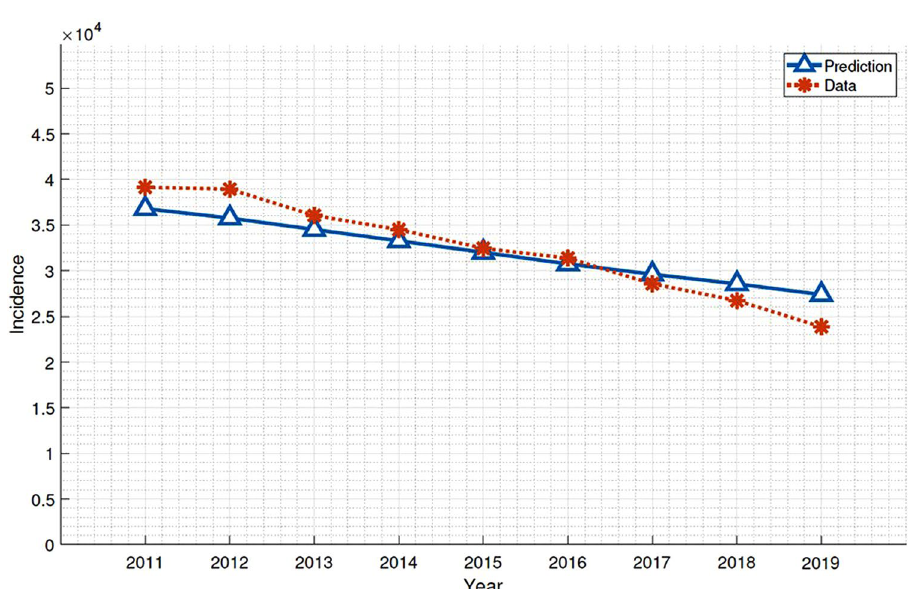
Figure 3. TB incidence by model prediction and the annual TB report data in 2011 –